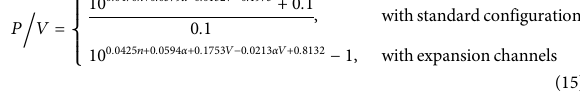
power input of 54.1 W m − 3 (the power input of Panckow et al. (2019) was taken from Figure 4 of his publication. For this purpose 100 data points of the temporal representation of the power input were digitized and integrated with the trapezoidal rule and divided